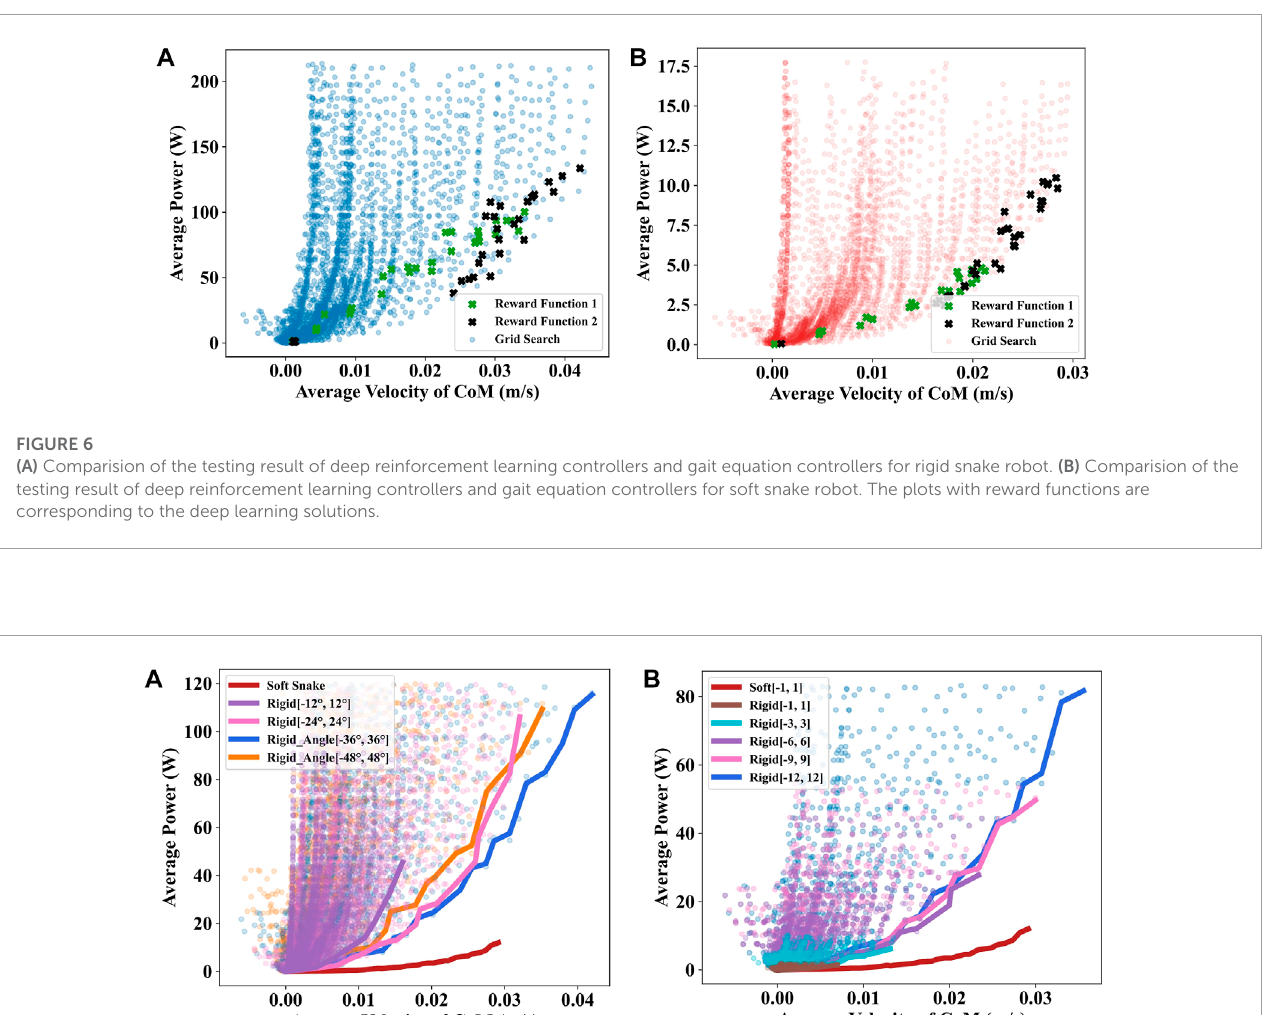
Frontiers in Robotics and AI